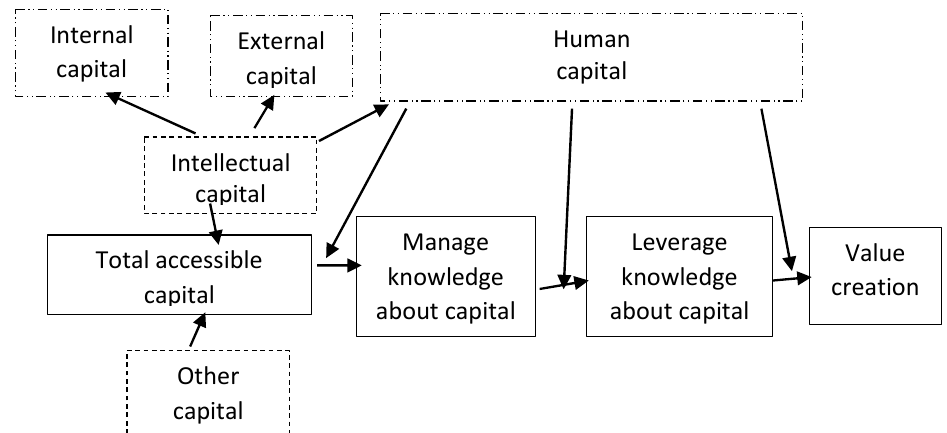
Figure 5. The nexus between intellectual capital and knowledge management in firms.